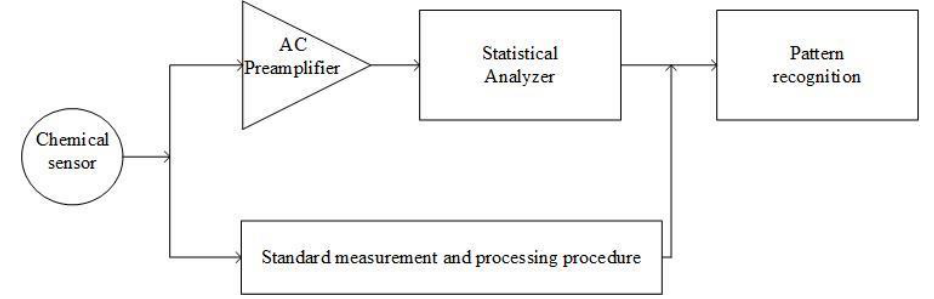
Figure 3. Schematic diagram for fluctuation-enhanced chemical sensing.